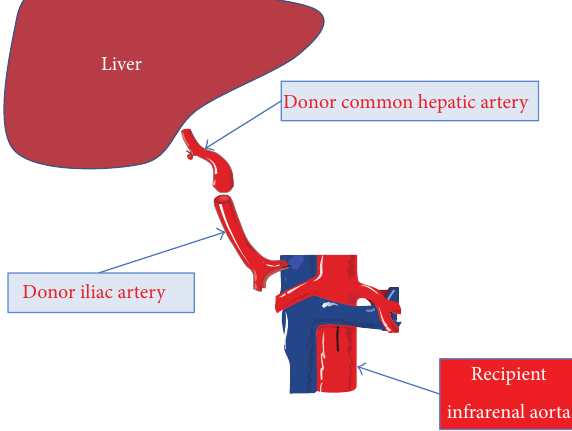
Figure 1: Schematic representation of the arterial conduit between the donor common hepatic artery and recipient infrarenal